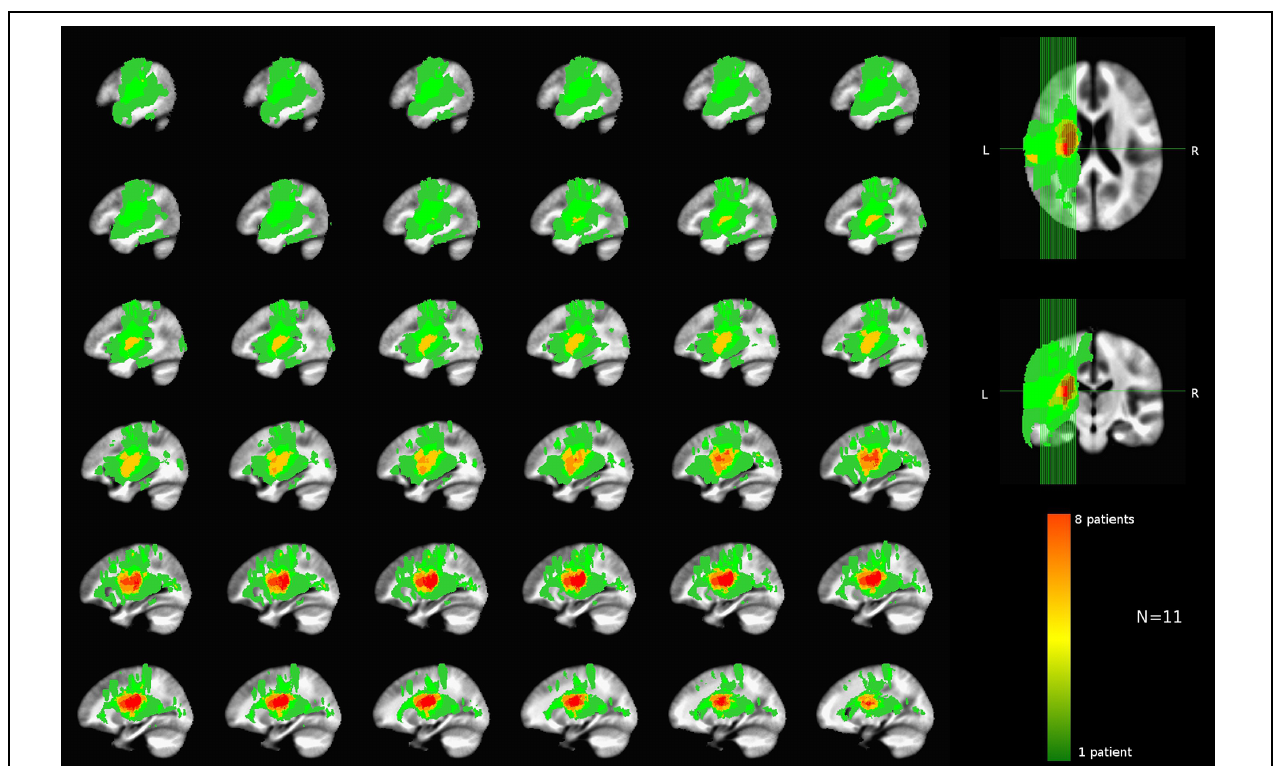
FIGURE 3 | Group lesion coverage map of the left hemisphere. All patients were included in the map, however, the greatest number of patients with overlapping lesions was eight as indicated on the color bar.